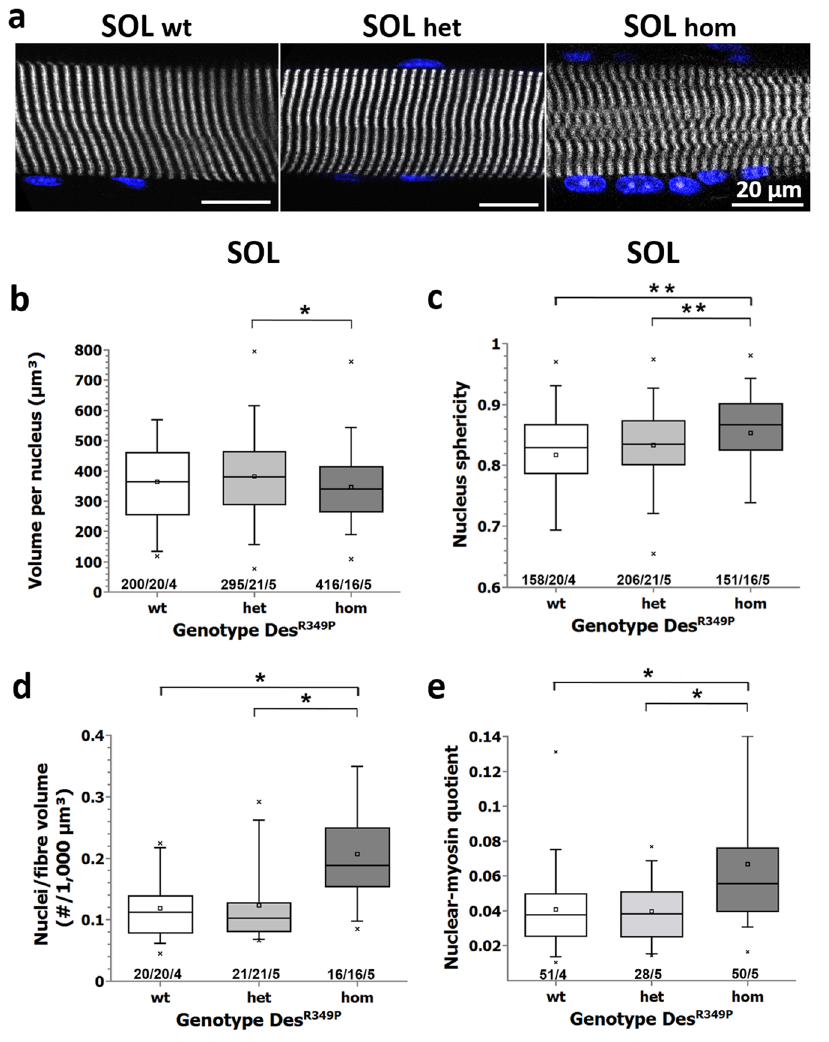
Des R349P knock-in mouse showing the SHG (grey) and counterstained nuclear signal (blue). Although the volume per nucleus in fibers from hom animals was not different to wt ( b ), other morphological parameters were significantly different, e.g. hom fibers showing an increased rounded shape (sphericity) ( c ), or vastly increased number of nuclei per fiber volume ( d ), the latter two also compared to het Des R349P mutations. The nuclear-to-myosin volume ratios were also largely increased in the hom Des R349P genotype ( e ). (c/n/m) depicts (c) cell nuclei in (n) fibers from (m) mice. * p < 0.05, ** p < 0.01, one-way ANOVA with Bonferroni-correction. Scale bar: 20 µ